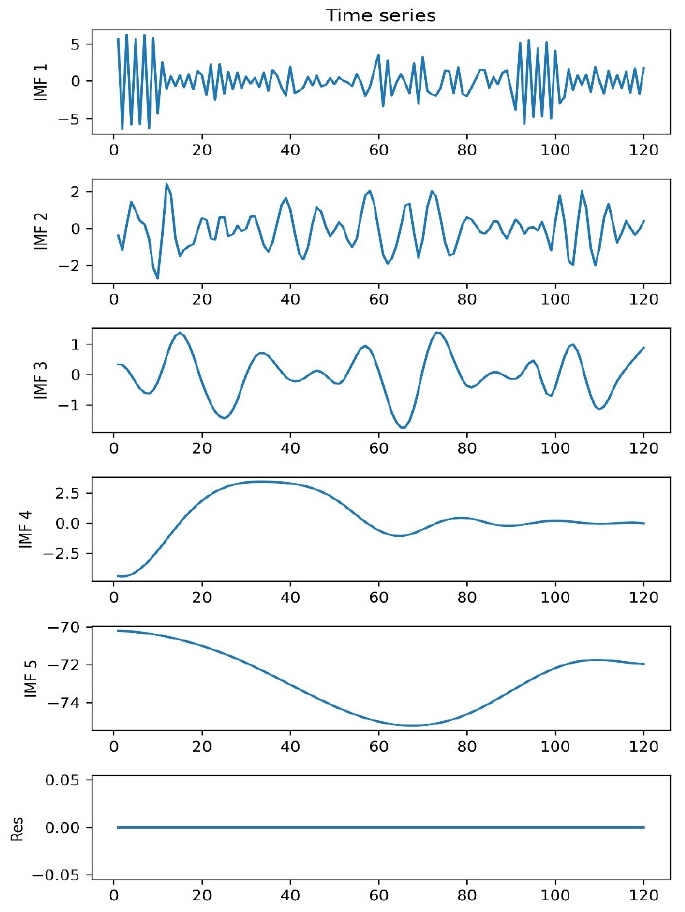
Figure 9. 5 IMFs and a residual function.